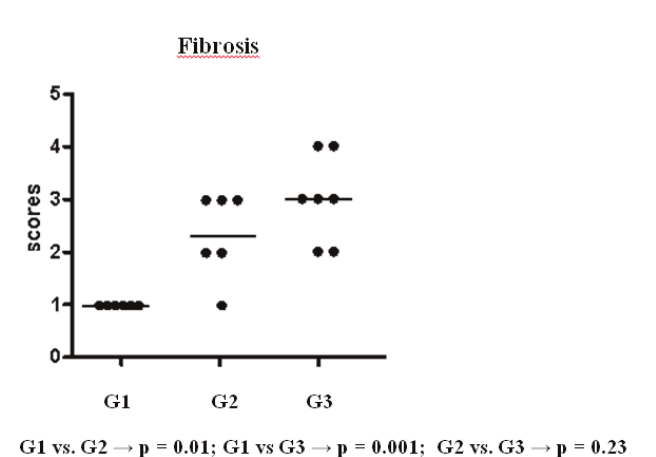
FIGURE 6 - The presence of fibrosis analyzed in all groups by the Mann-Whitney with 95% of confidence interval. There were no statistical differences comparing Group 2 with 3.